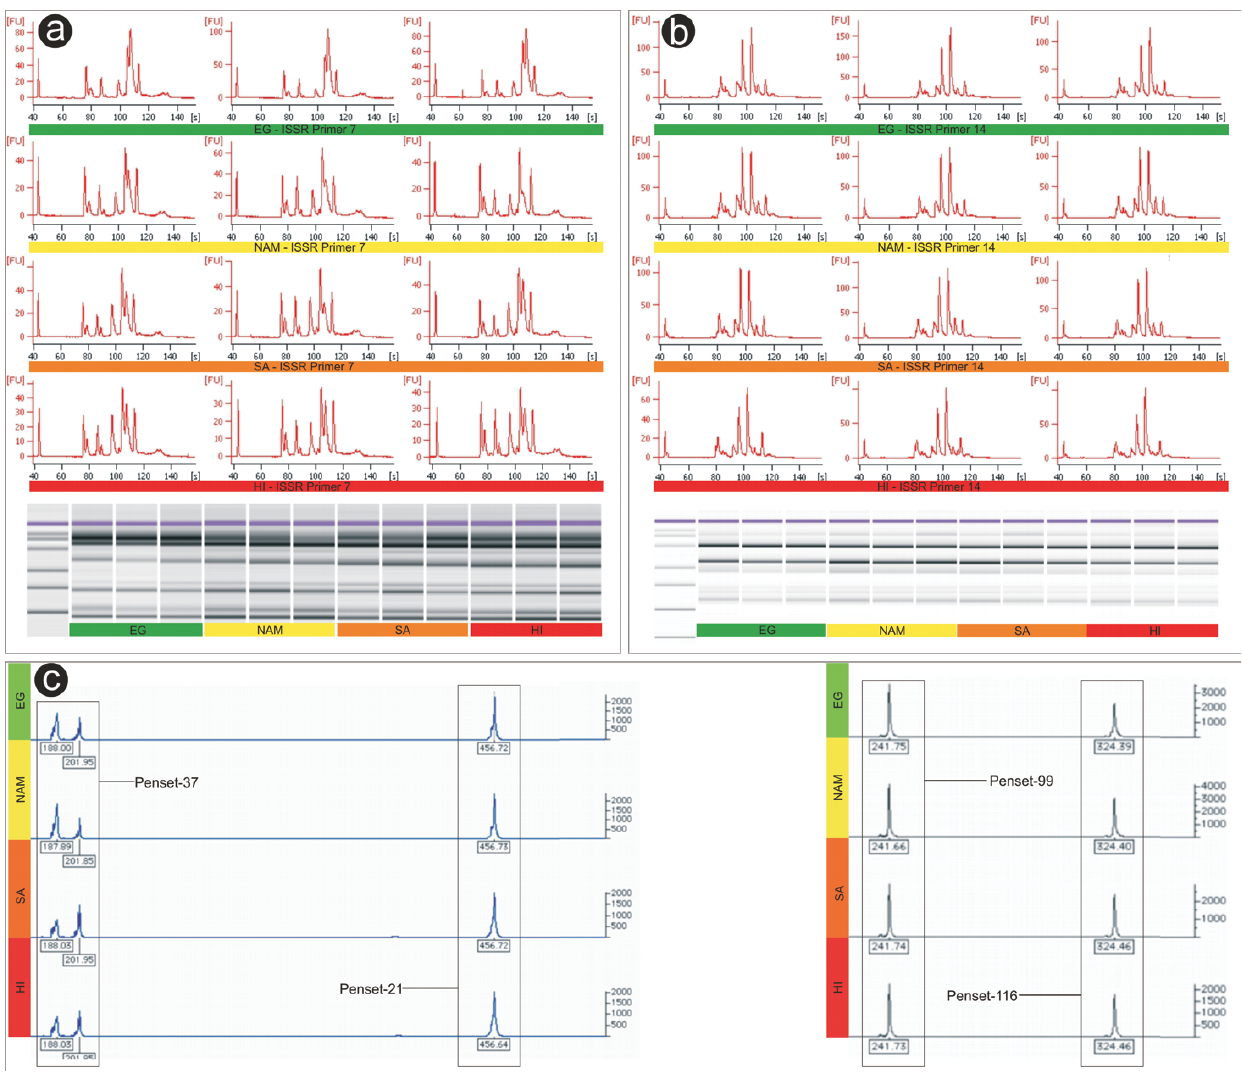
Figure 2. Results for selected molecular markers. ISSR banding pattern data for primer 7 (a) and primer 14 (b) indicating no variation between Egypt (EG, green), Namibia (NAM, yellow), South Africa (SA, orange) and Hawaii (HI, red). Electropherograms and their associated gel images are shown for 3 individuals from each of these locations. An illustration of 4 selected microsatellite loci (c) shows complete fixation for all alleles between all locations.